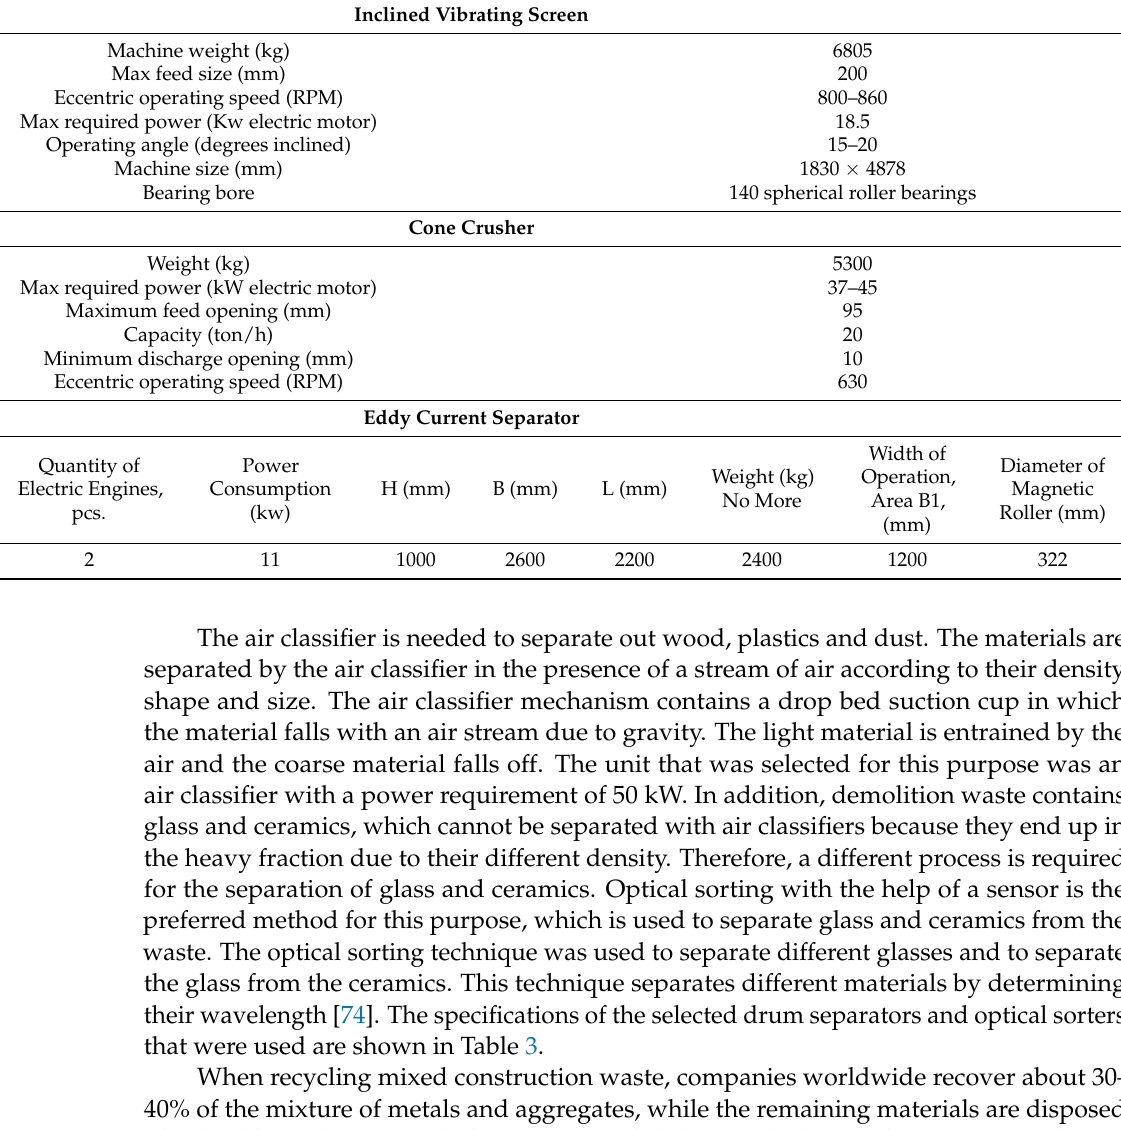
Table 2. Specifications for crushing, screening and eddy current separating